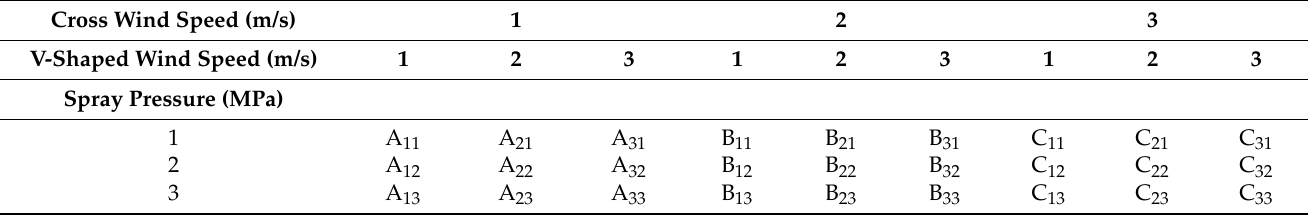
Table 2. Design of three-level simulation experiments of droplet deposition.